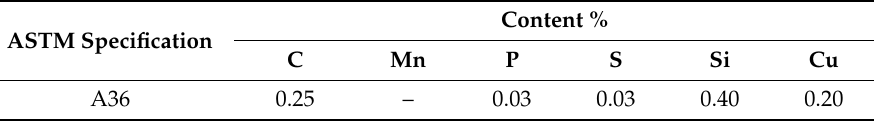
Table 1. Chemical composition of A36